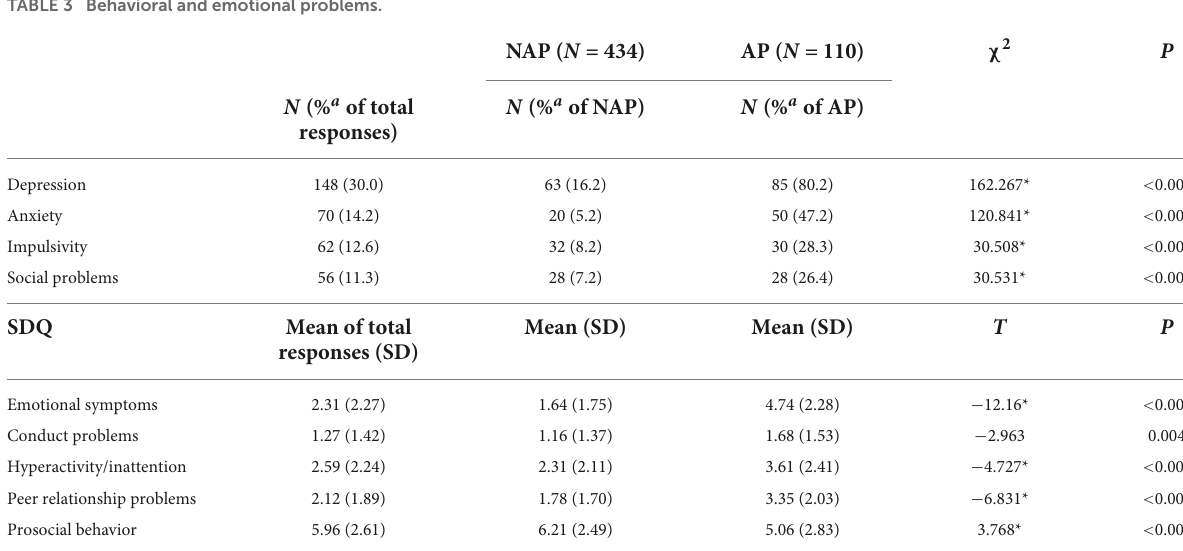
TABLE 3 Behavioral and emotional problems.